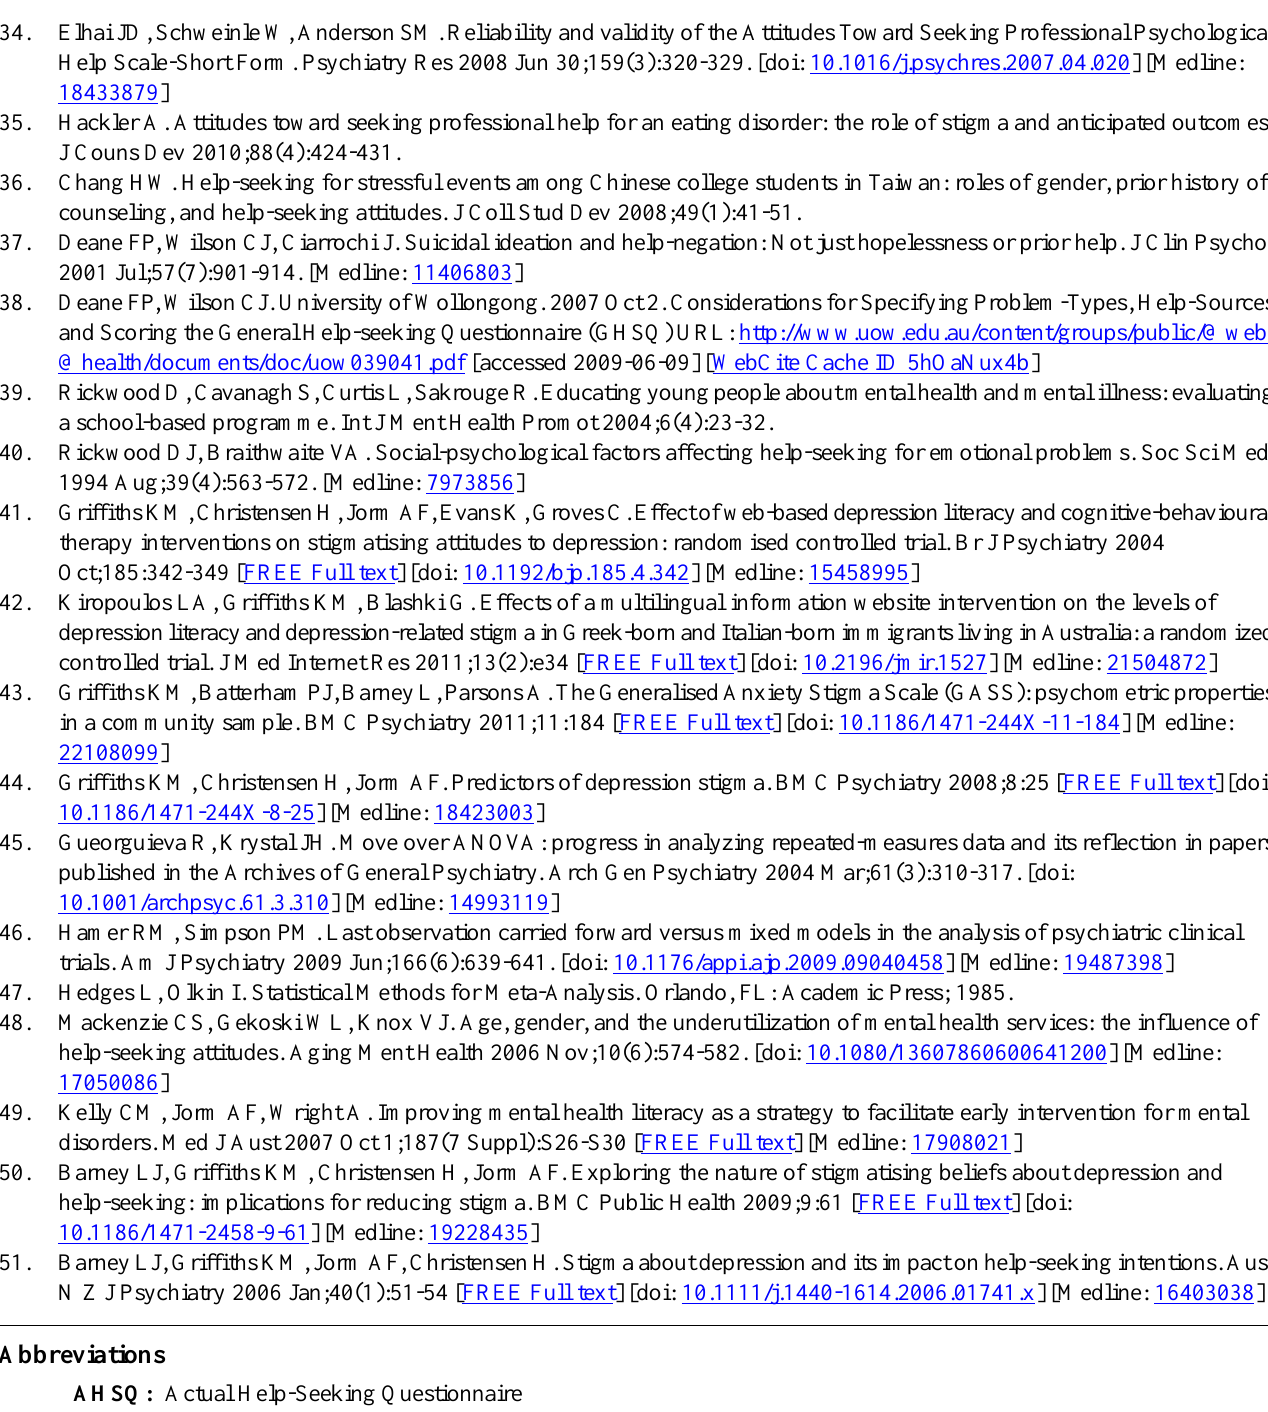
TEAMS: The Elite Athlete Mental Health Strategy